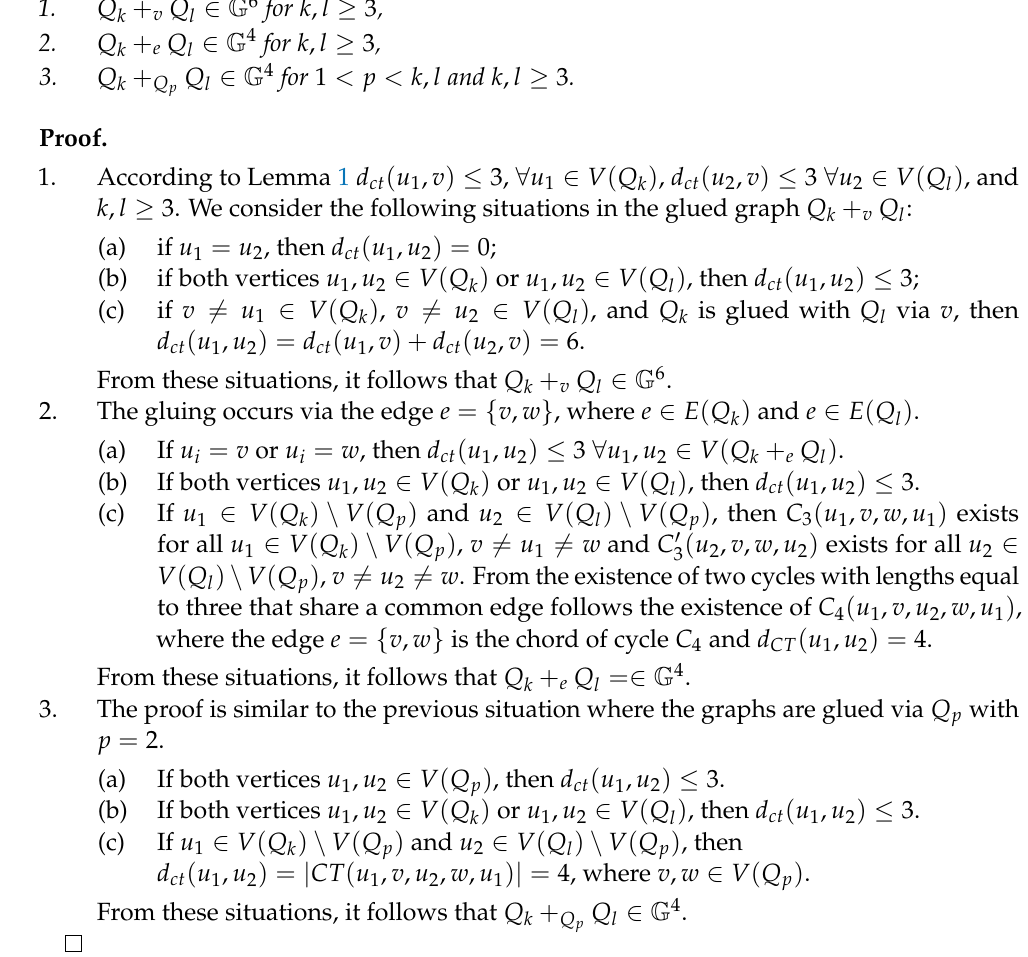
u 1 , v 1 , w 1 u 2 , v 2 , w 2 . Figure 3. Glued graph from graphs G 1 and G 2 with isomorphism f : { } → { }